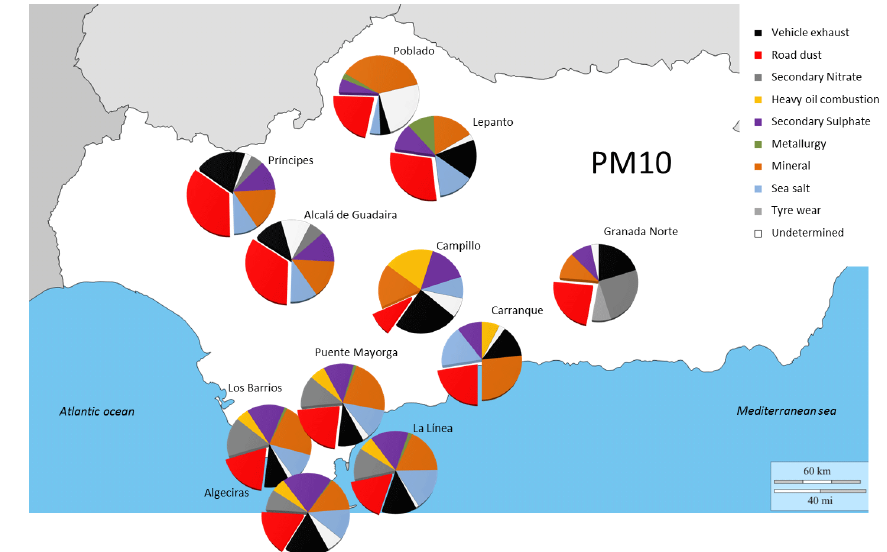
Fig. 4. Pie chart of average source contributions to PM 10 levels observed at the 11 stations in Andalusia.